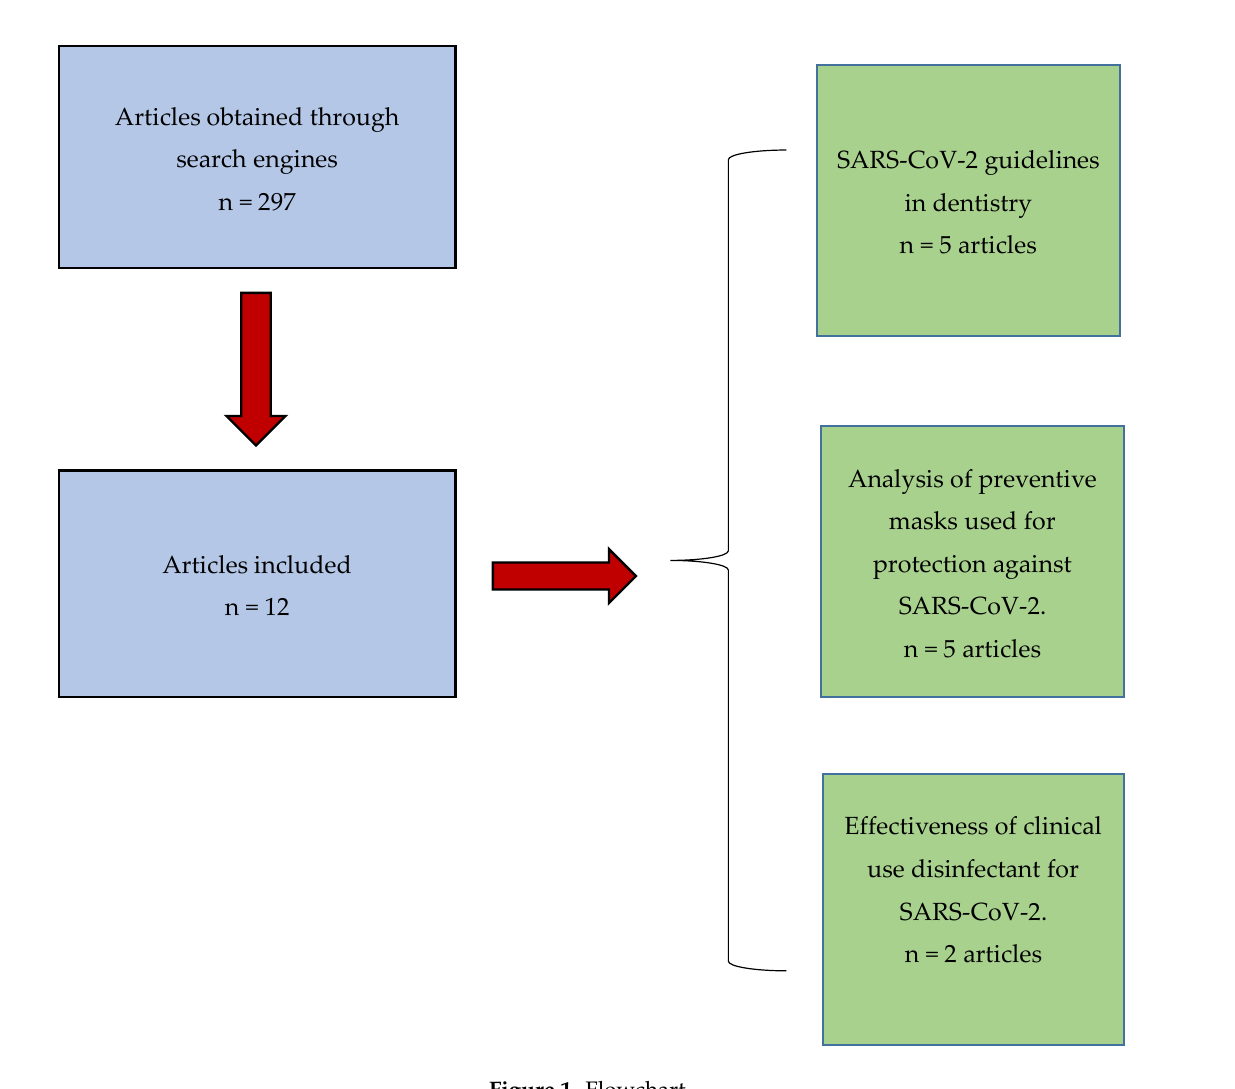
Figure 1. Flowchart.